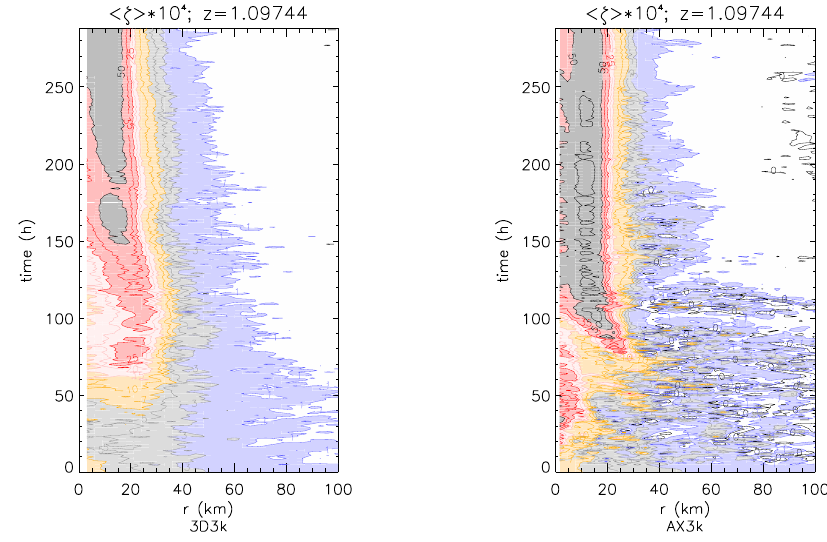
Fig. 3. Radius-time plots of relative vorticity ζ times 10 4 s − 1 at z = 1 km a) (left) from the simulation 3D3k after azimuthal averaging and b) (right) from simulation AX3k spanning the complete 12 day simulation. Contours (s − 1 ) are -1 and 1 (blue); 3 and 5 (gray); 7 and 10 (orange); 15 and 20 (pink); 25 and 35 (red); and 50 and 75 (black).